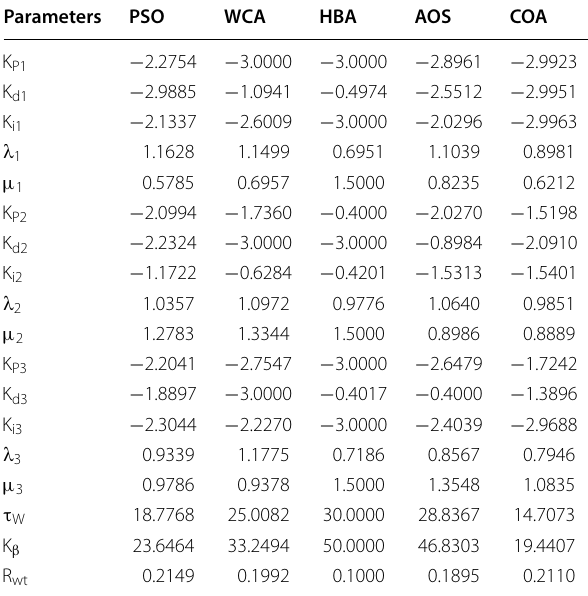
Table 3 Optimal parameters of FOPID controllers